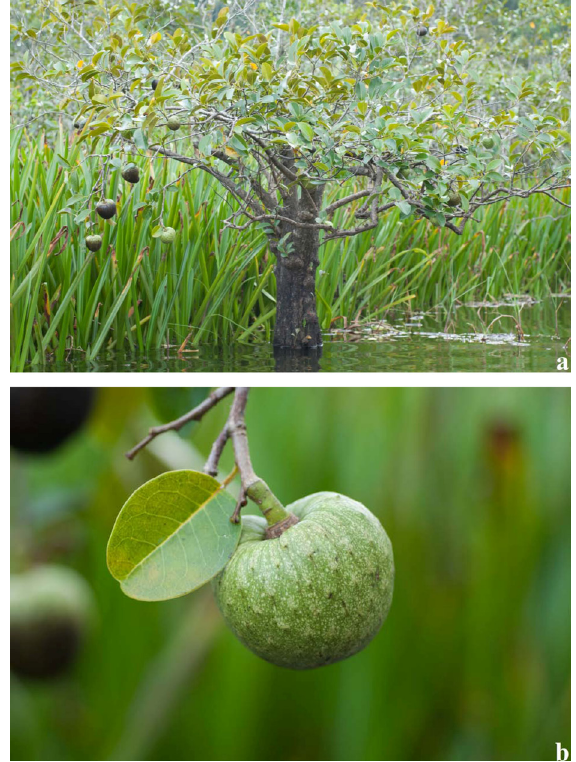
Figure 1 - Annona glabra tree ( a ) and fruit ( b ) in the Massaguaçu River Estuary, Brazil (23º37’20’’S and